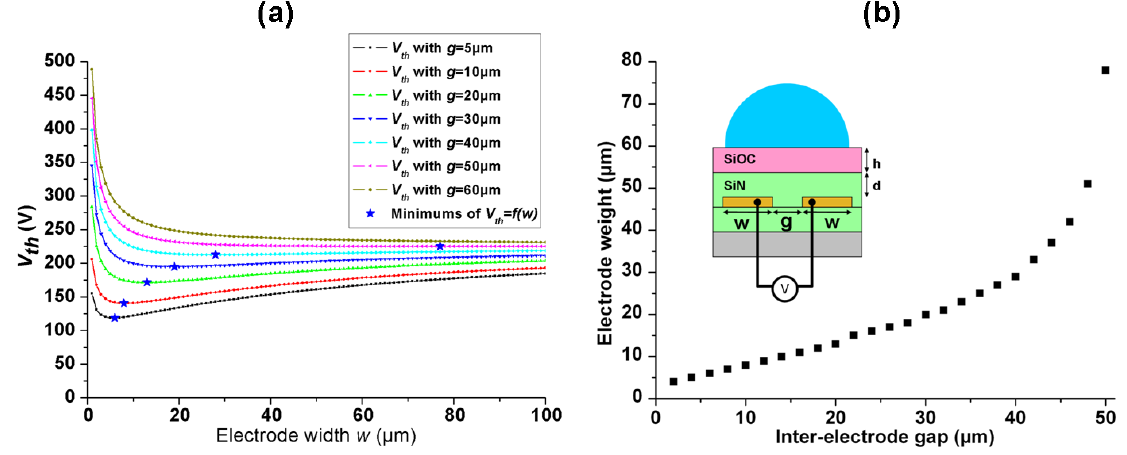
Figure 4. (a) Threshold voltage actuation as a function of the electrode width w for different inter-electrode gap g . Blue star labels represent the minimum of the function V = f(w) for each given inter-electrode gap. (b) Electrode width w as a function of the th gap g , corresponding to the minimum threshold actuation voltages V . (Both figures are th obtained with f = 10f , σ = 6 × 10 −6 S m −1 , ε = 80 , d = 100 nm SiN ( 3.6   ) and c liq liq SiN h = 100 nm SiOC ( 75.2   SiOC